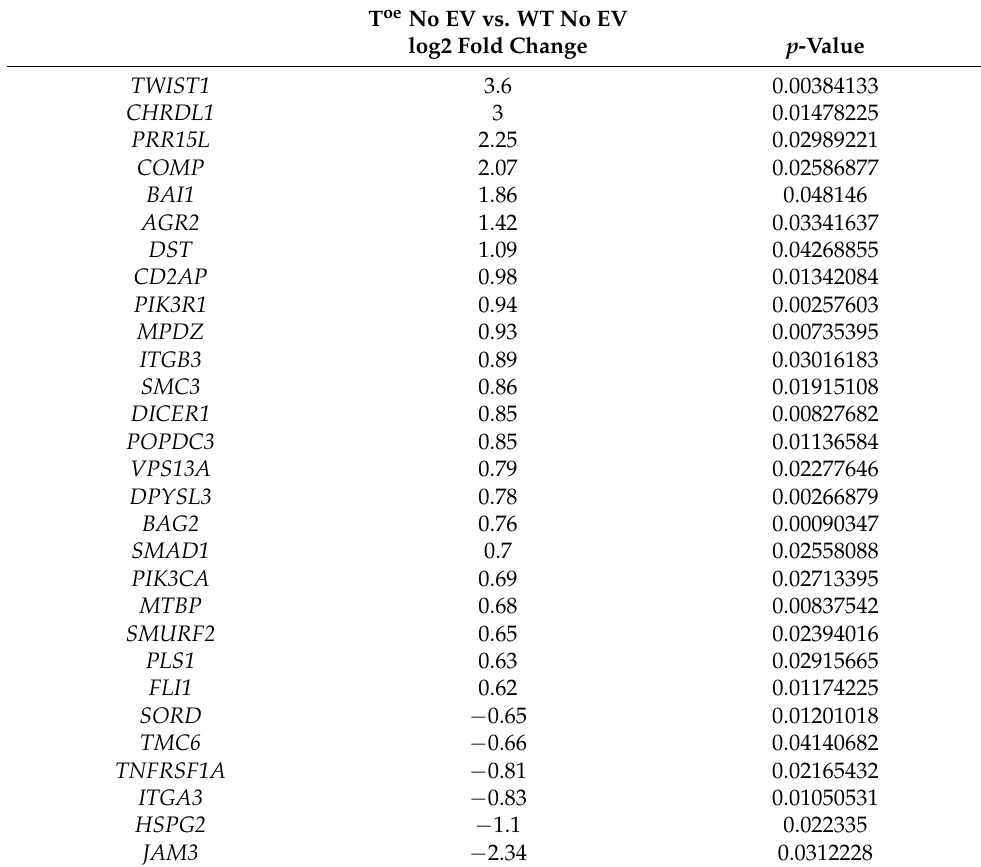
Table 6. Differentially expressed in T oe versus